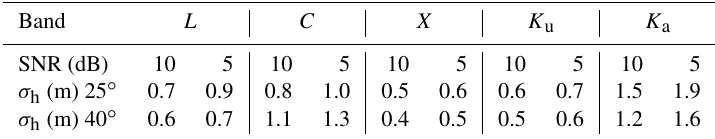
Table 4. Effect of a low signal-to-noise ratio (SNR) on the relative height error σ h . Band L C X K u SNR